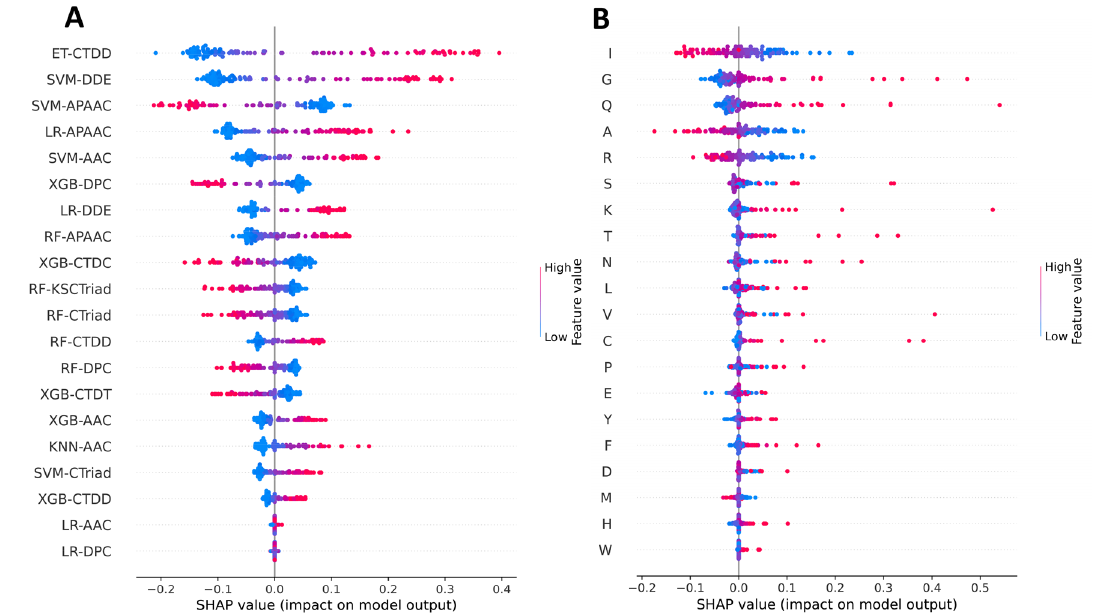
Figure 5. SHAP values of 20 important features used for AMYPred-FRL ( A ) and SVM-AAC ( B ). SHAP values represent the directionality of the informative features, where positive and negative SHAP values represent positive (AMYs) and negative (non-AMYs) predictions.